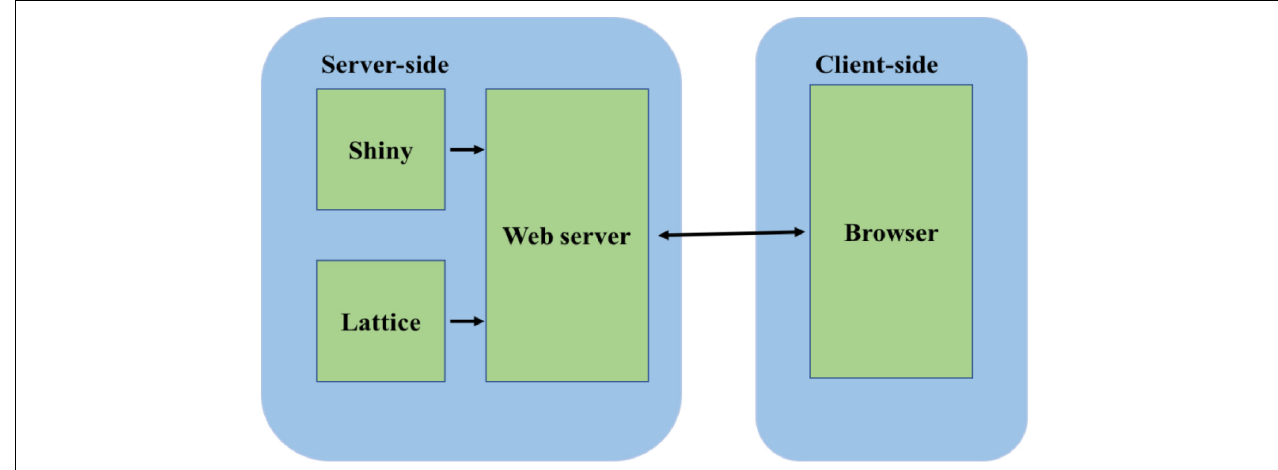
FIGURE 1 | Software architecture of the simulator. The server side consists of the Shiny package and the Lattice package. The Shiny package is used for server-side computations. The Lattice package is used for graphical display. The computations and the graphs are served to the client browser through the webserver built into the Shiny